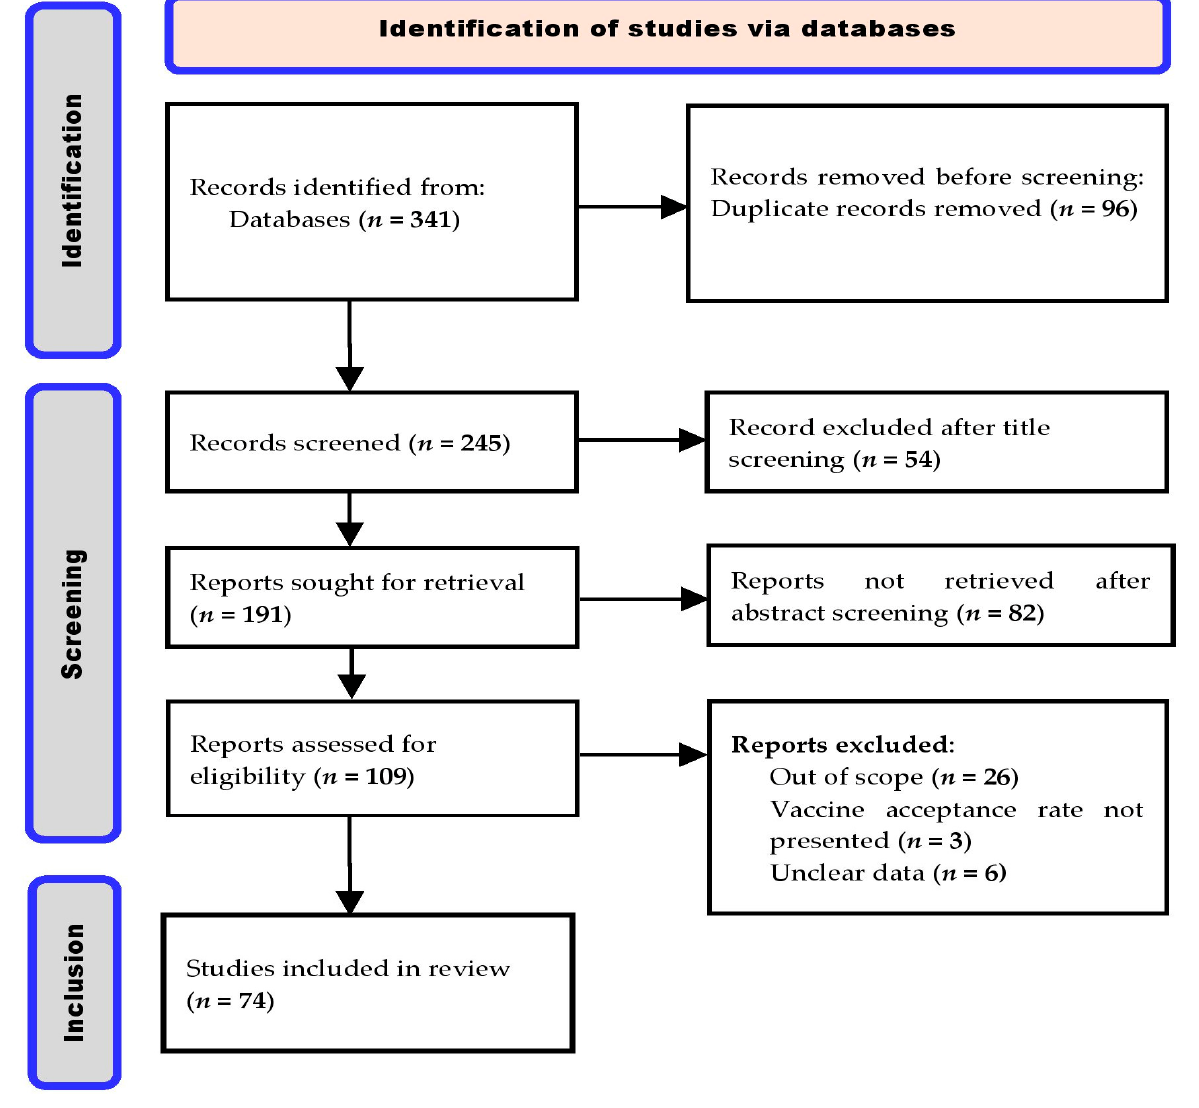
Figure 2. PRISMA flow chart for the search, identification, screening, and inclusion criteria for the 74 published articles reviewed in this study. Table 1. Reported COVID-19 vaccine acceptance rates in African countries between 1 January 2020 and 5 September